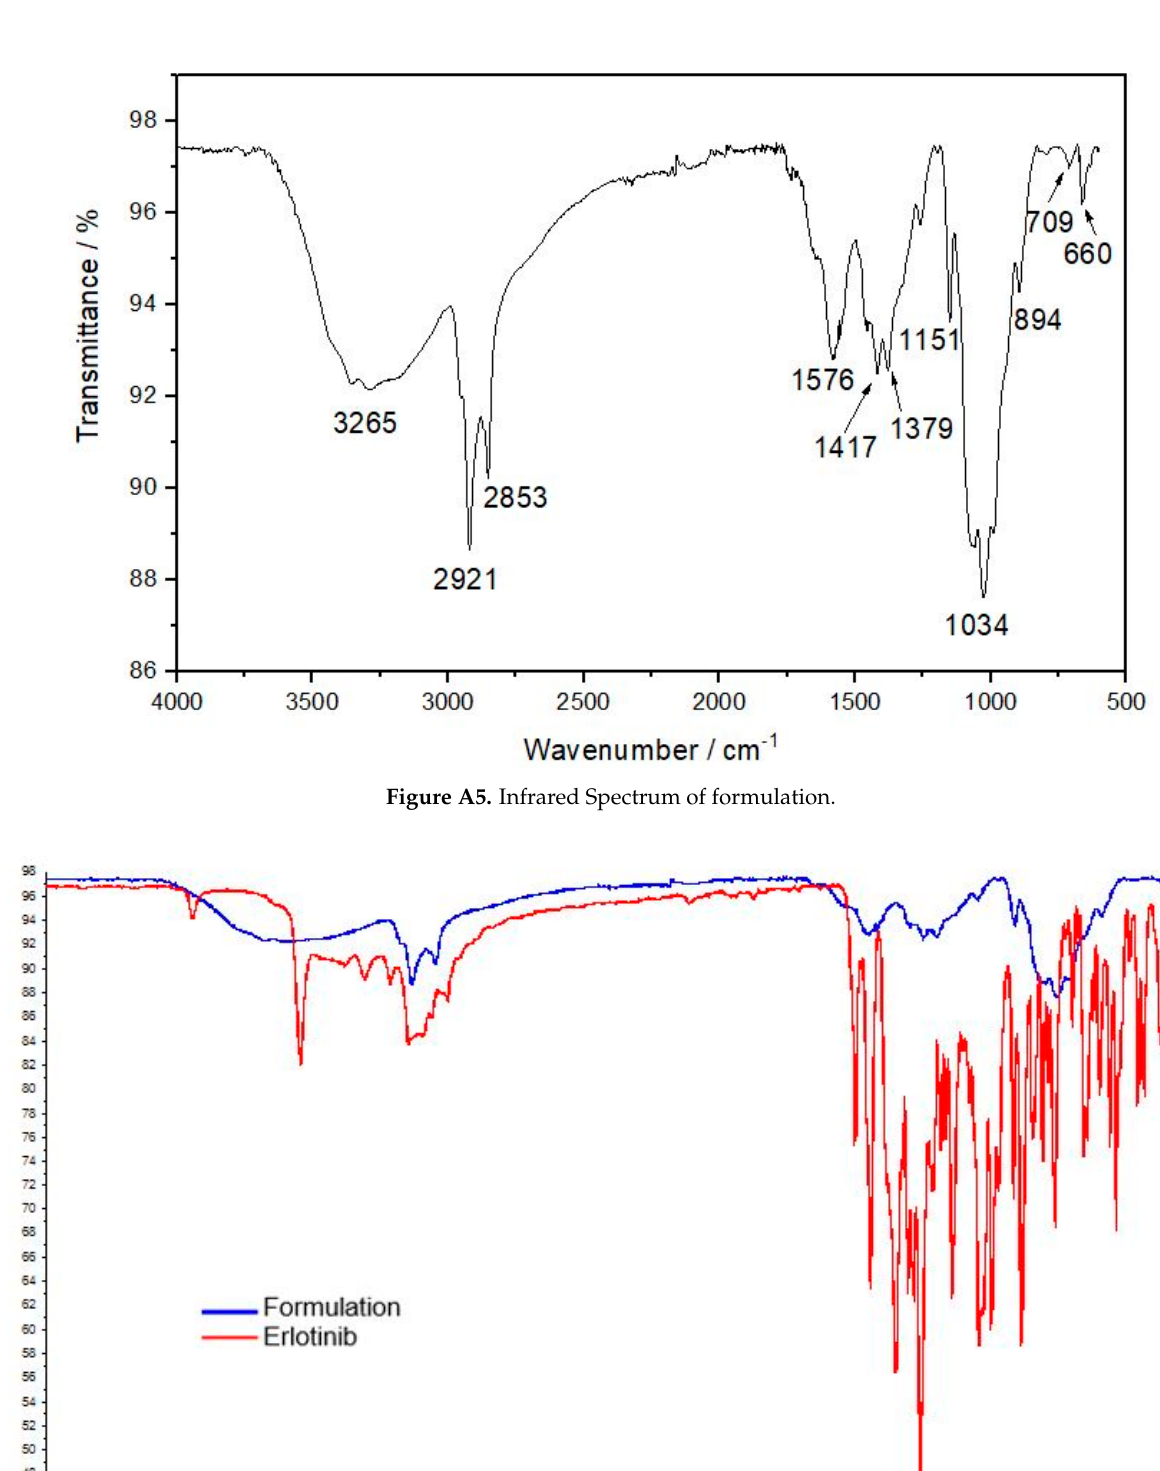
Figure A4. Magnetite infrared spectrum.